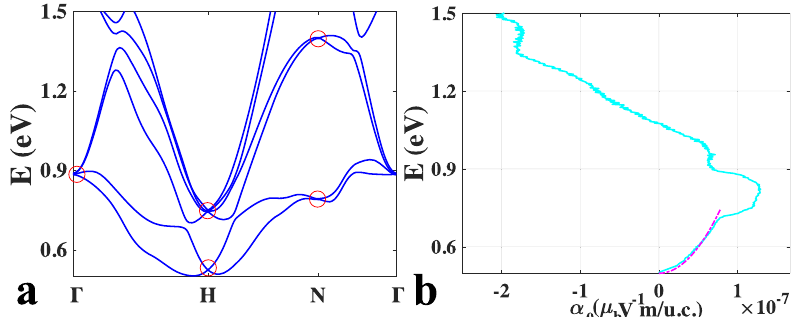
Fig. 2 The isotropic longitudinal magnetoelectric response in K 2 Sn 2 O 3 . a The band structure of K 2 Sn 2 O 3 . The red circles highlight the Kramers Weyl point as well as a multi-fold fermion in this material. b The isotropic longitudinal magnetoelectric susceptibility α 0 as a function of conduction band energy. Below E = 0.7eV, the magnetoelectric response can be well described by the analytical result from Eq. (8) with m = 1.4 m e , ℏ v = − 70 meV ⋅ nm, τ = 6ps. The sudden increase of the magnetoelectric response near E = 0.7eV is due to the emergence of the bands associated with the multi-fold fermion at H point of the Brillouin zone. The magenta dashed line denotes the analytical derived α 0 in Eq. (8) while the numerically obtained α 0 is plotted in a cyan solid